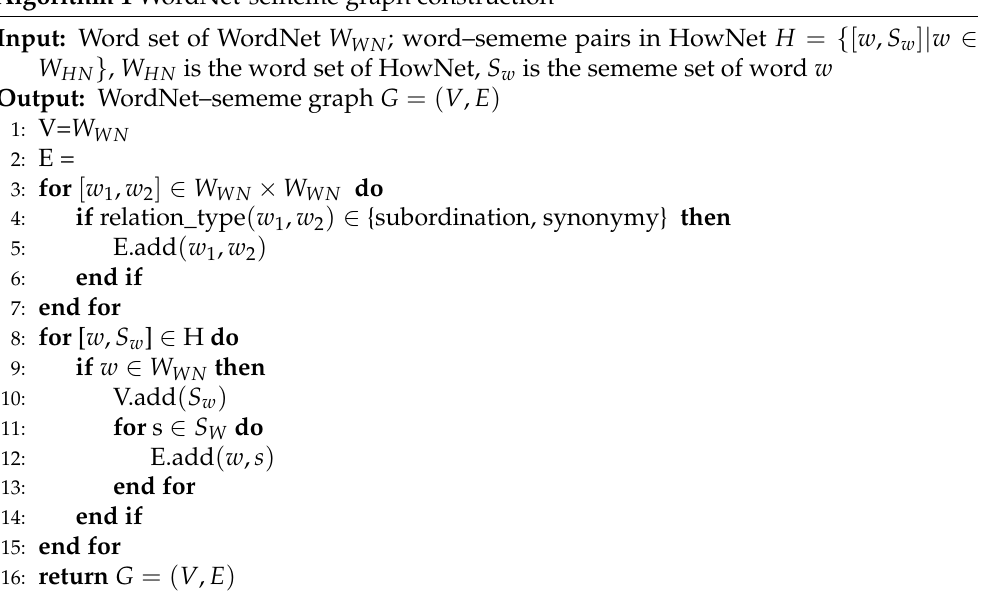
Algorithm 1 WordNet-sememe graph